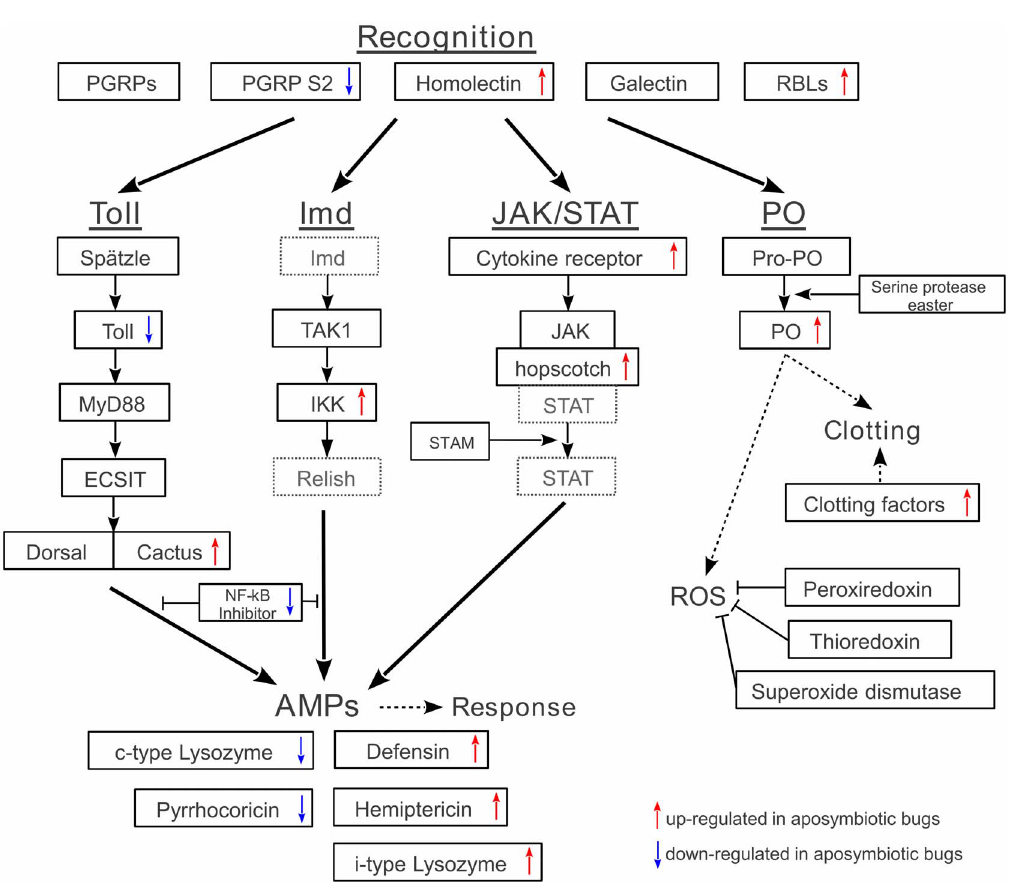
Fig. 2. Overview of immune response related transcripts with their respective regulation pattern. Detected transcripts for the different immune pathways are indicated in solid boxes, relevant proteins in the pathway that were not found are depicted in dashed boxes. Transcripts with more than twofold changes in expression between symbiotic and aposymbiotic bugs are indicated by arrows (red 5 up-regulated in aposymbiotic bugs, blue 5 down-regulated in aposymbiotic bugs).